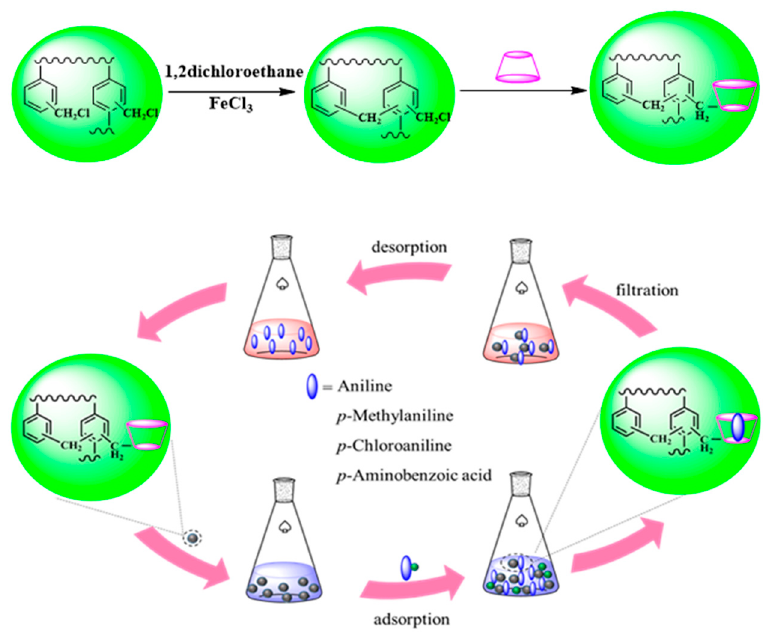
Figure 1. Schematic presentation for the synthesis of a β -cyclodextrin-modified hyper-crosslinked polymer (CDM-HCP) and the adsorption process of amines.